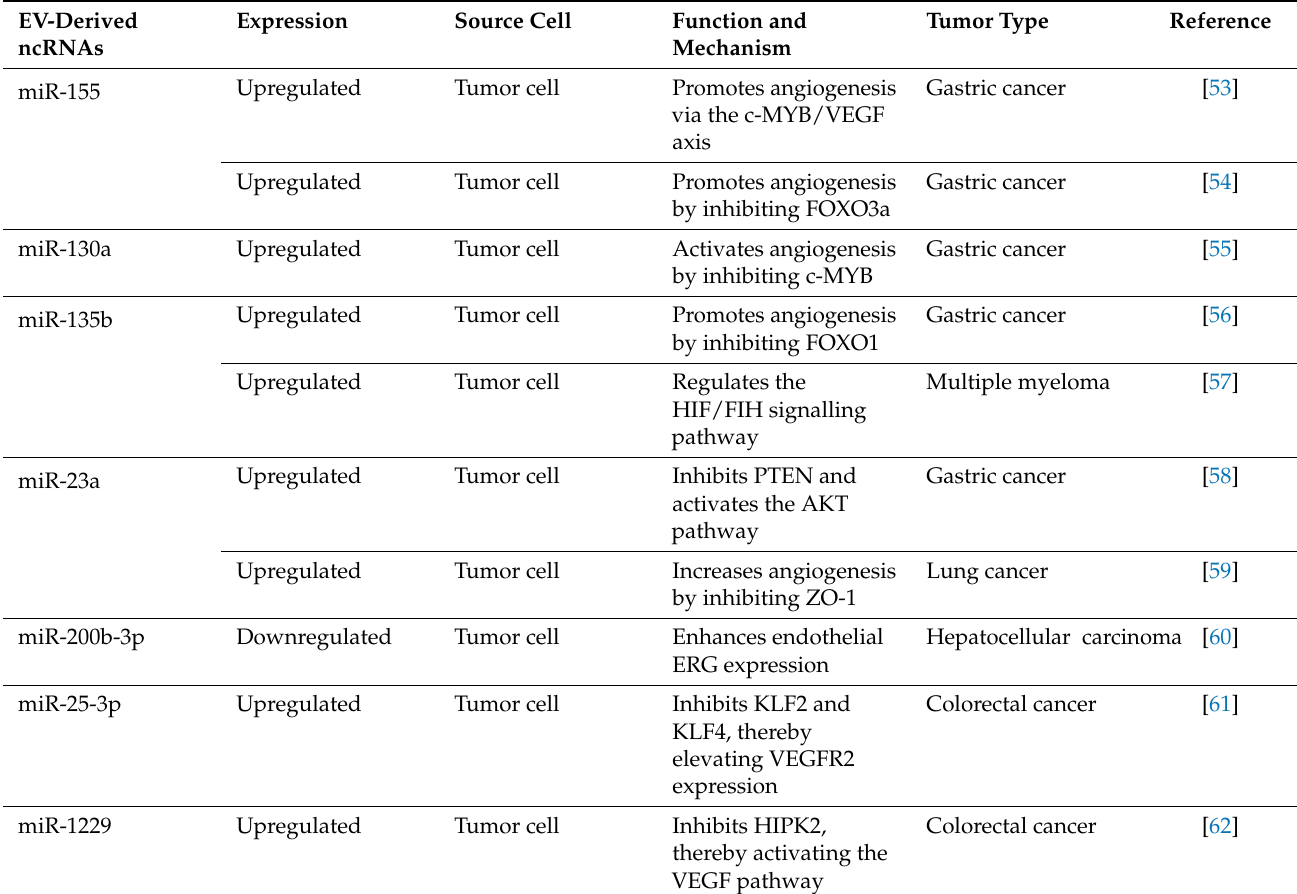
Table 1. The emerging roles of EV-derived ncRNAs in tumor